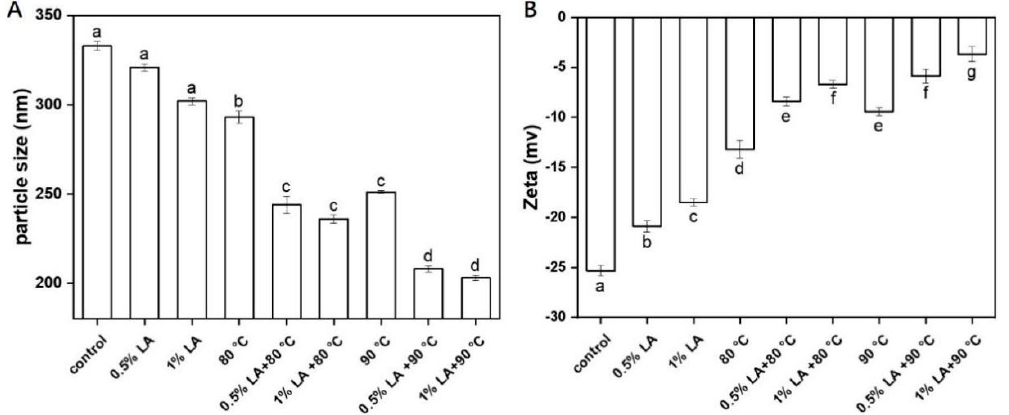
Figure 5. Changes in C. perfringens spore particle size ( A ) and zeta potential ( B ) after different treatments for 30 min. Different lowercase letters indicate significant differences among treatments ( p <